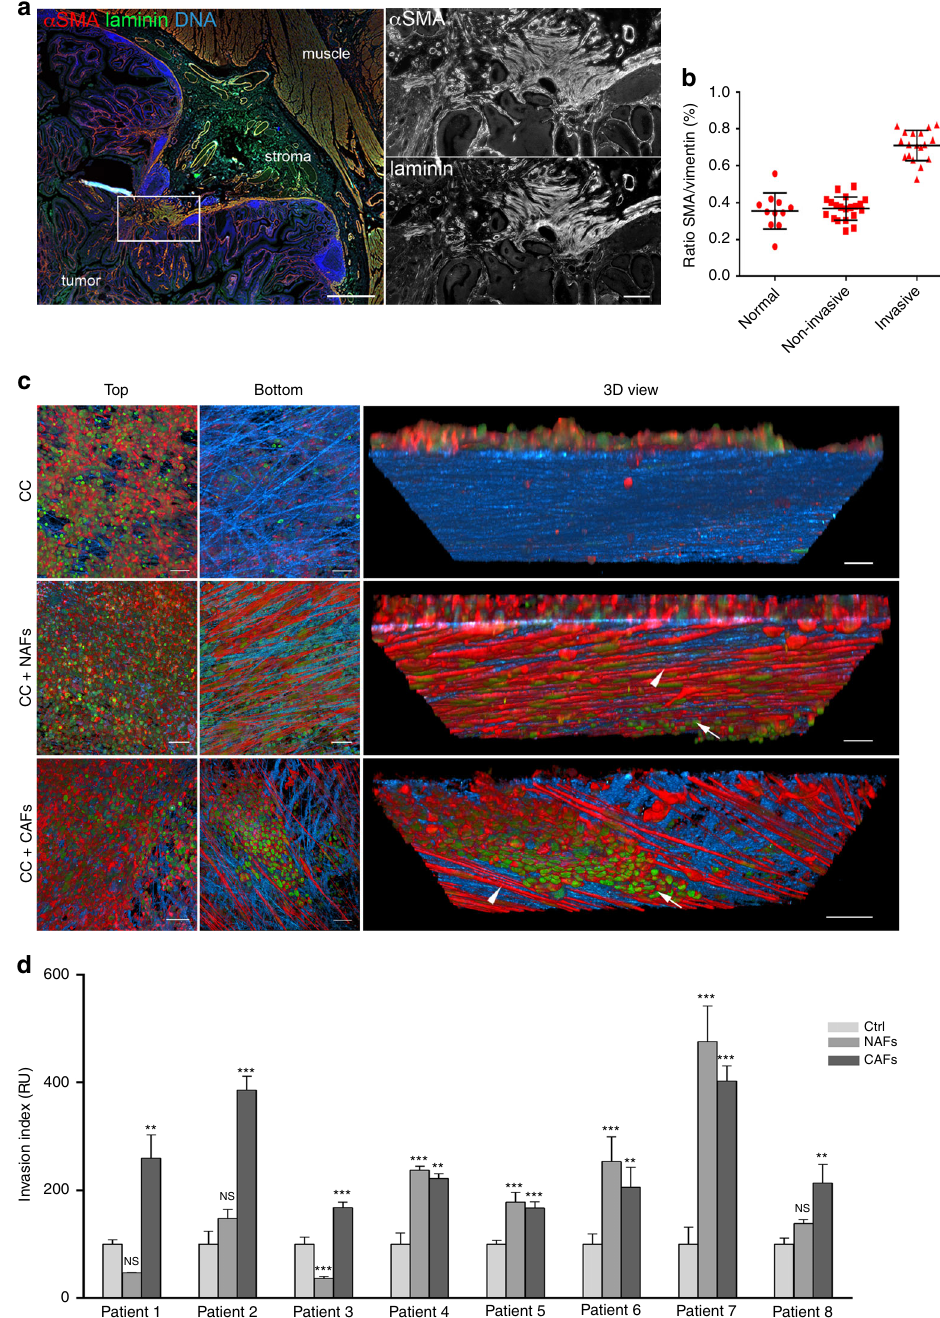
Fig. 1 CAFs stimulate cancer cell invasion through the basement membrane. a Human colon carcinoma in situ. Basement membrane visualized by laminin staining (green), CAFs with α SMA (red), and DNA (DAPI, blue). Scale bar, 1000 µ m. Boxed region was magni fi ed; Invasive area showing accumulation of CAFs, and disorganization of the basement membrane. Scale bar, 200 µ m. b Quanti fi cation of proportion of CAFs in human colon tissues: adjacent to the tumor (normal), non-invasive, and invasive carcinoma. Area occupied by CAFs was calculated as a ratio between α SMA and vimentin staining. For each patient fi ve different areas were averaged. * p < 0.001, ANOVA, Krusskal – Wallis methods. c HCT116 colon cancer cells (CC) were cultured atop mouse mesenteric BM (top view) for 10 days, either alone or in the presence of NAFs or CAFs embedded in type I collagen matrix on the other side of the mesentery (bottom view). 3D view shows bottom part of the mesentery. Cells visualized by staining the actin cytoskeleton (phalloidin, red) and DNA (DAPI, green). The mesentery is detected by re fl ection (blue). Arrows show cancer cells and arrow heads show CAFs. Scale bars, 20 µ m. d Quanti fi cation of cancer cell invasion through the mesenteric BM in the presence of NAFs or CAFs from eight different patients. The invasion index was calculated as the number of cancer cells per fi eld on the underside of the BM. NAFs and CAFs from each patient are normalized to their respective controls. For each patient-derived CAFs and NAFs, and their respected controls about n = 5 – 12 fi elds were scored from one or two independent experiments. Mean ± s.e.m. *** p < 0.0001; ** p < 0.001; * p < 0.05; ANOVA, Dunn ’ s, or Holm – Sidak